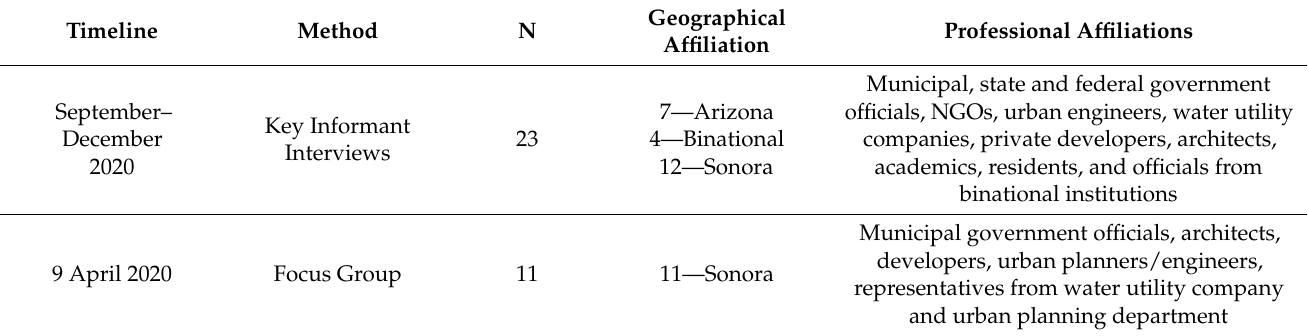
Table 2. Overview of Study Participants and timeline.